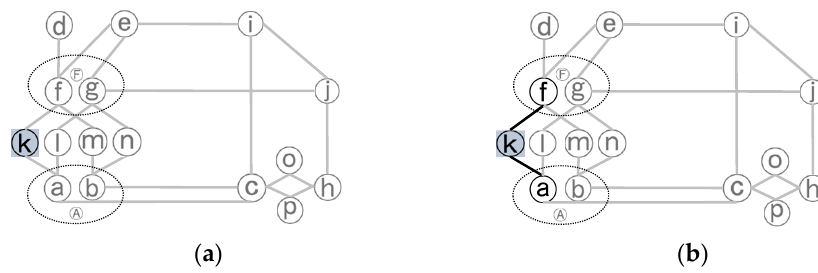
Figure 5. The seed node of secondary road k ( a ) and its S expanding ( b ). (5) Multi-line processing: for each node x in P that is a counterpart